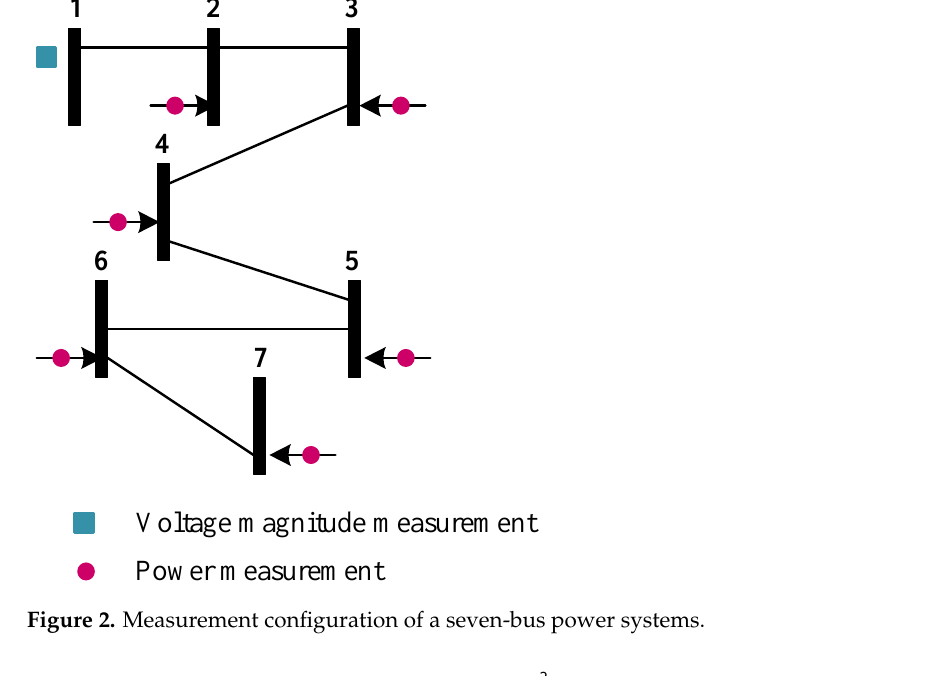
Figure 2. Measurement configuration of a seven-bus power systems. The deviations of lower and upper bound from Δ𝑑 ingly set to be 1% by the approximation of measurement data. The node voltages are shown in Figure 3 at the bound value of 𝜀